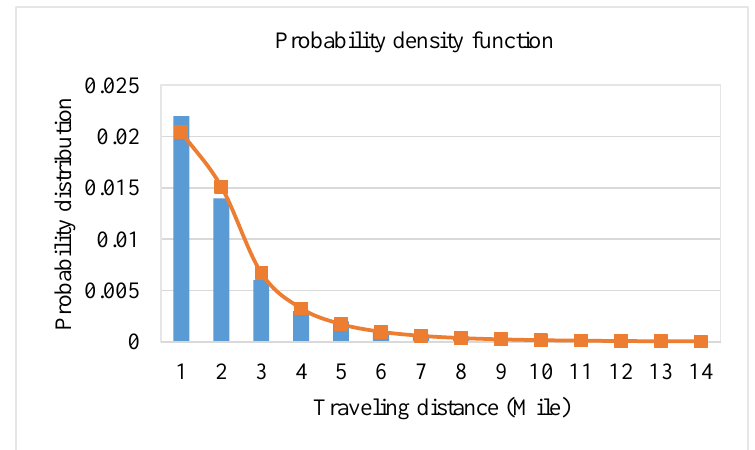
Figure 3. Probability density function of the driving distance.